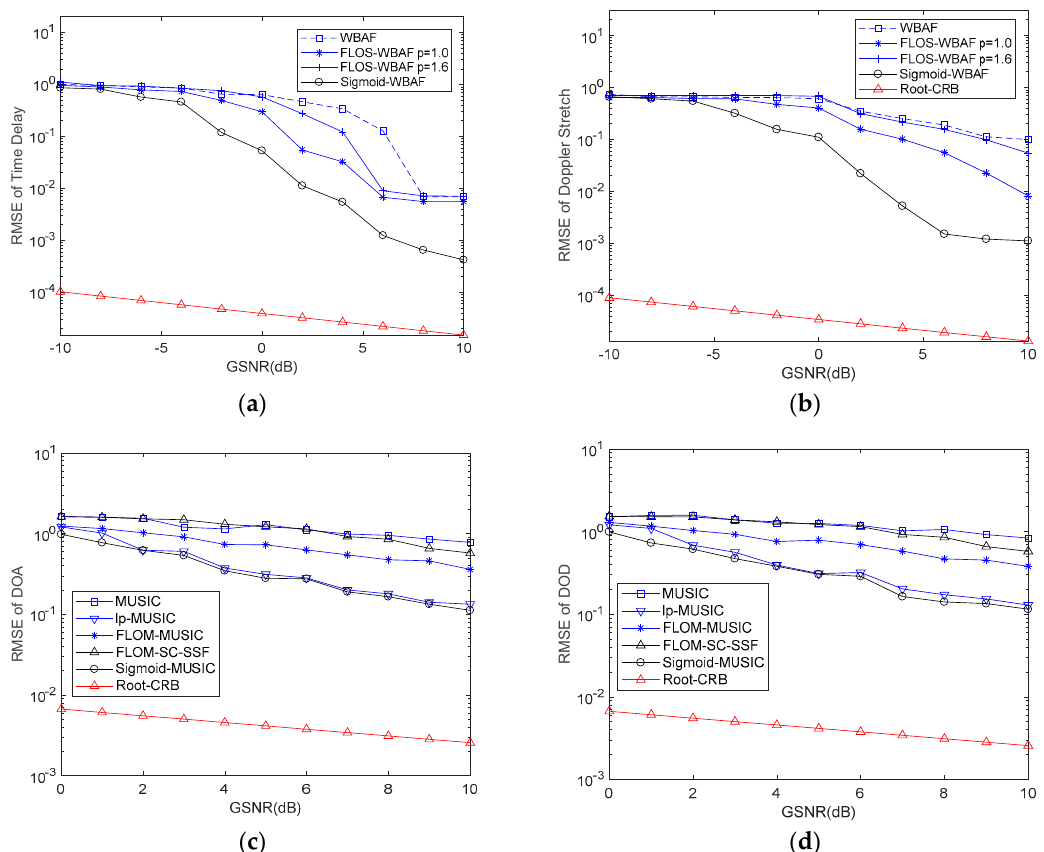
Figure 7. Root-mean-square errors (RMSEs) of parameters versus generalized signal-to-noise ratio (GSNR). ( a ) RMSE of the time delay; ( b ) RMSE of the Doppler stretch; ( c ) RMSE of the direction-of-departure (DOD); ( d ) RMSE of the direction-of-arrival (DOA).